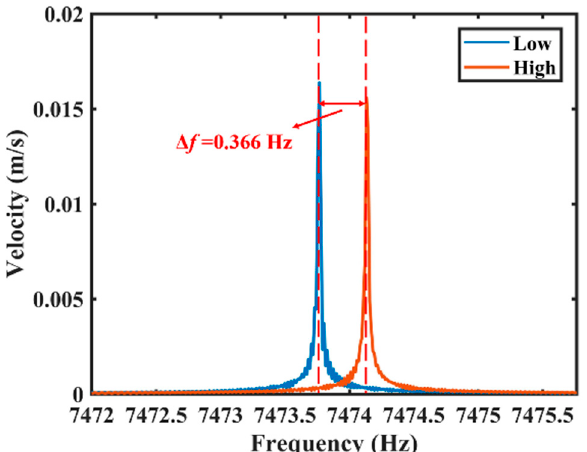
Figure 7. The FFT results of the vibration velocity of two vibrating modes with different frequencies. The blue line represents exciting in the direction of the low-frequency principal axis, and the red line represents exciting in the direction of the high-frequency principal axis.